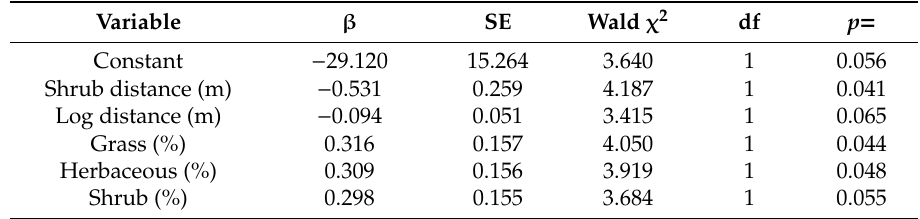
water, rock, and bare ground were omitted from the analysis due to high zero